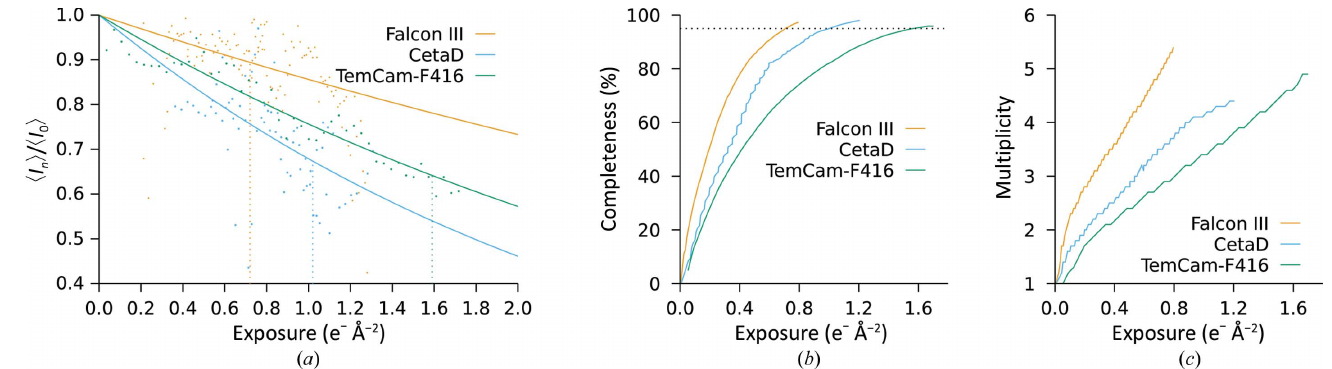
Figure 1 Mean intensity, completeness and multiplicity as a function of exposure. ( a ) For each camera, the integrated intensities on the subset of frames in the ( (cid:4) 30 (cid:3) , +30 (cid:3) ) tilt range were averaged; this reduces systematic effects on the intensities arising from longer paths through the sample at higher tilt. The reflections in the resolution range common to all data sets (20.0–2.70 A˚ ) were then fitted to a function of the form A cryst exp( (cid:4) B cam (cid:7) x ), where A cryst was refined for each crystal and B cam was refined for each camera. The dotted vertical lines indicate the exposure at which 95% completeness was obtained. ( b ) The exposure-dependency of the completeness was determined by merging only frames with an average exposure less than the given value. The dotted horizontal line marks 95% completeness. ( c ) In all cases, the multiplicity increases approximately linearly with dose, which implies that completeness is indicative of the amount of information recovered at the given